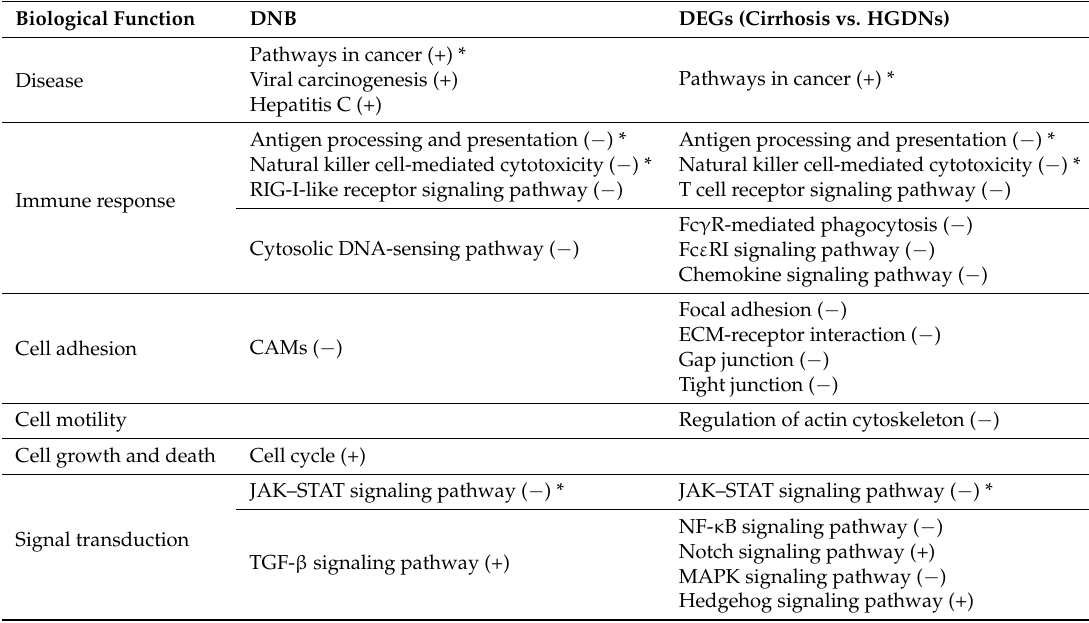
Pathways in cancer (+) *Viral carcinogenesis (+)